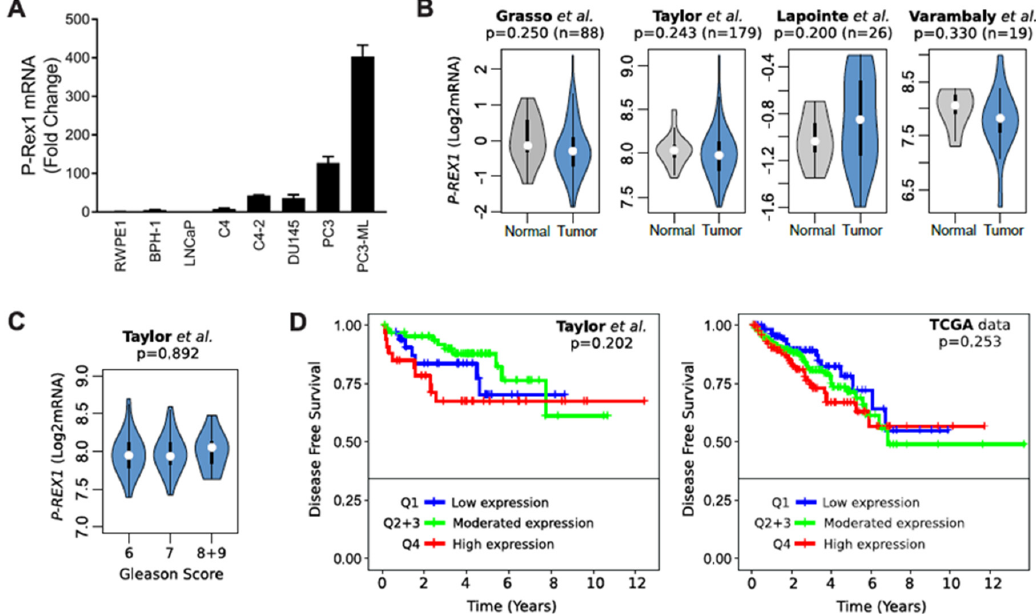
Figure 3. Expression of P-Rex1 in prostate cancer. ( A ) mRNA expression level of P-Rex1 in the indicated prostate cancer cell lines was assessed by RT-qPCR. ( B ) Violin plots showing the status of P-Rex1 mRNA expression in prostate cancer tumor and normal tissues. ( C ) Violin plots showing P-Rex1 mRNA expression relative to Gleason score. ( D ) Kaplan–Maier curves showing the disease-free survival of patient groups selected according to the PREX1 quartile expression. Analysis was performed using publicly available datasets from ( B ) Grasso et al. [31], Lapointe et al. [32], and Varambaly et al. [33]. ( B , D ) Taylor et al. [34] and ( D )